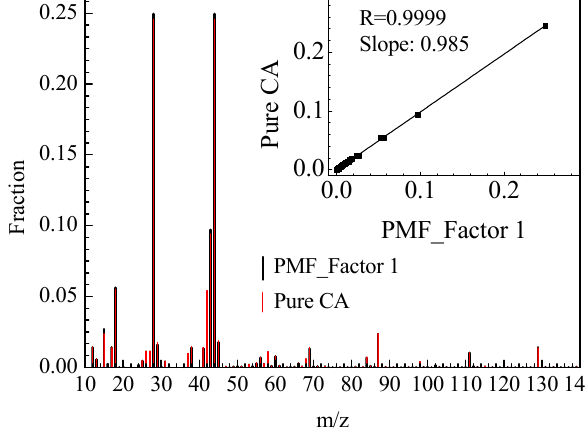
Figure 4. Comparison between the mass spectra of factor 1 from PMF analysis and pure CA directly measured by the C-ToF-AMS. The inset graph is the correlation of their corresponding signal in-